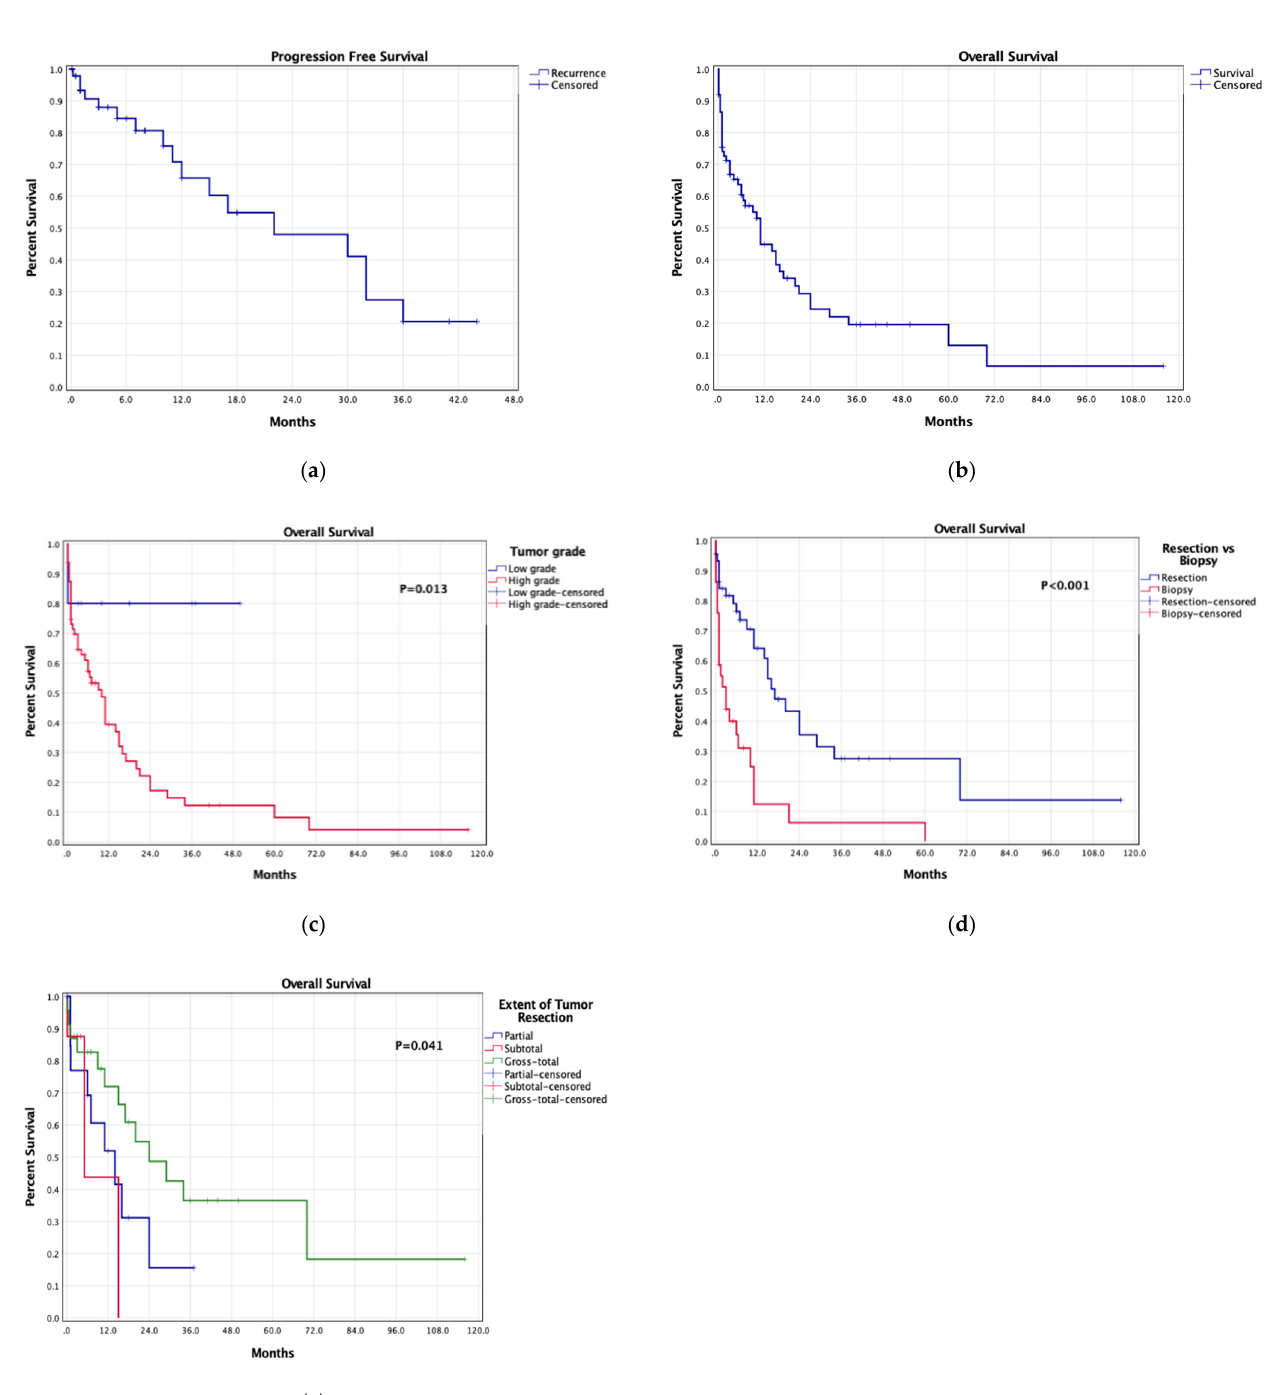
Figure 2. Kaplan–Meier survival curves: ( a ) pooled progression-free survival, ( b ) pooled overall survival, ( c ) overall survival based on tumor grade, ( d ) overall survival based on resection versus biopsy in patients with high-grade G-I-CC receiving adjuvant treatments, ( e ) overall survival based on the extent of tumor resection in patients with high-grade G-I-CC receiving adjuvant treatments.